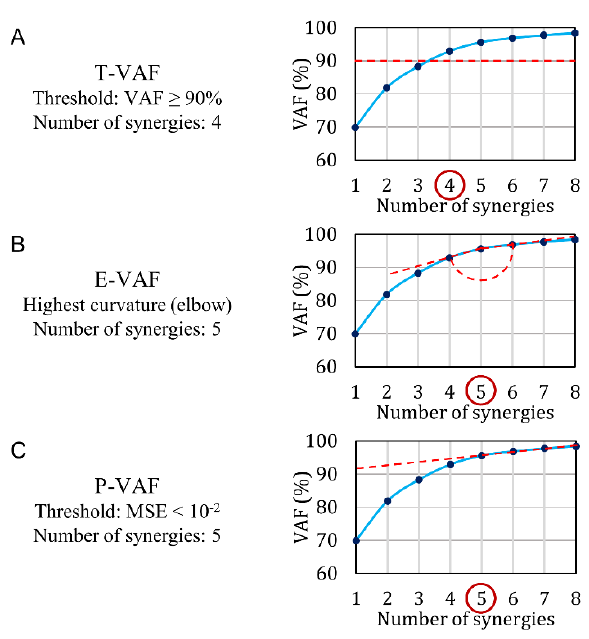
Figure 4. VAF-based methods used in the literature: ( A ) T-VAF, the most used method, ( B ) E-VAF, based on the curvature, and ( C ) P-VAF, based on the plateau. The reported VAF curve is calculated from the data of a real representative subject (the same for Figures 3 and 4).